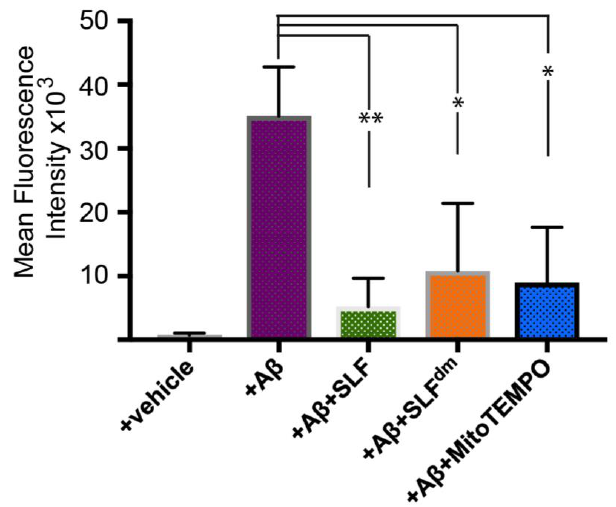
Figure 13. Quantification of mean fluorescence intensity signal in N2a neuronal cells (see Figure 12) treated with exogenous Aβ (1 μM in culture) and stained with anti-AβO antibodies (A11). The effect of SLF, SLF dm , and MitoTEMPO co-addition on intracellular accumulation of Aβ is given by the green, orange, and blue bars, respectively, and is compared to the +Aβ group. Statistical analysis of fluorescence intensity by one-way ANOVA gives * p < 0.01, ** p < 0.001, n = 3. Error bars represent the standard error, which is described in the Methods section.